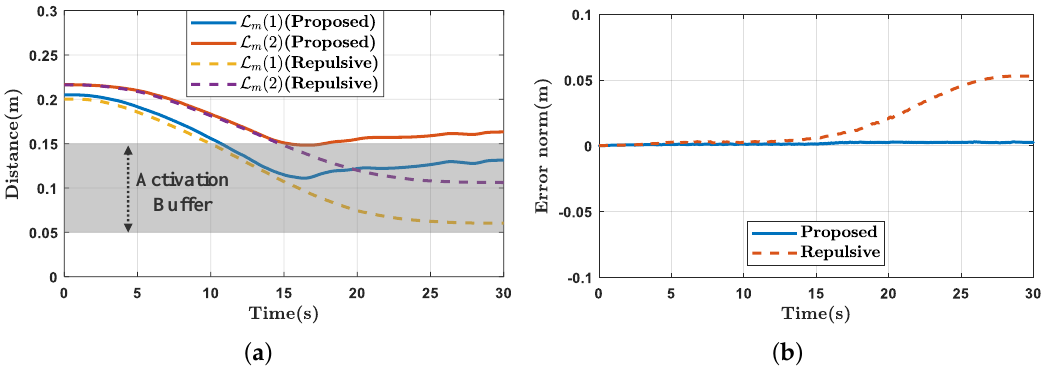
Figure 12. Experimental results of self-collision avoidance while tracking the predefined trajectory. ( a ) Distances of the link pairs ( L m ( 1 ) , L m ( 2 ) ); ( b ) the norm of the position